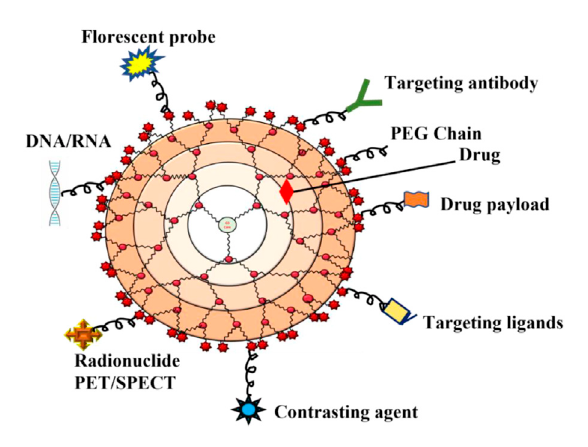
FIGURE 2 Schematic diagram that indicates the application of dendrimers in various biomedical fi